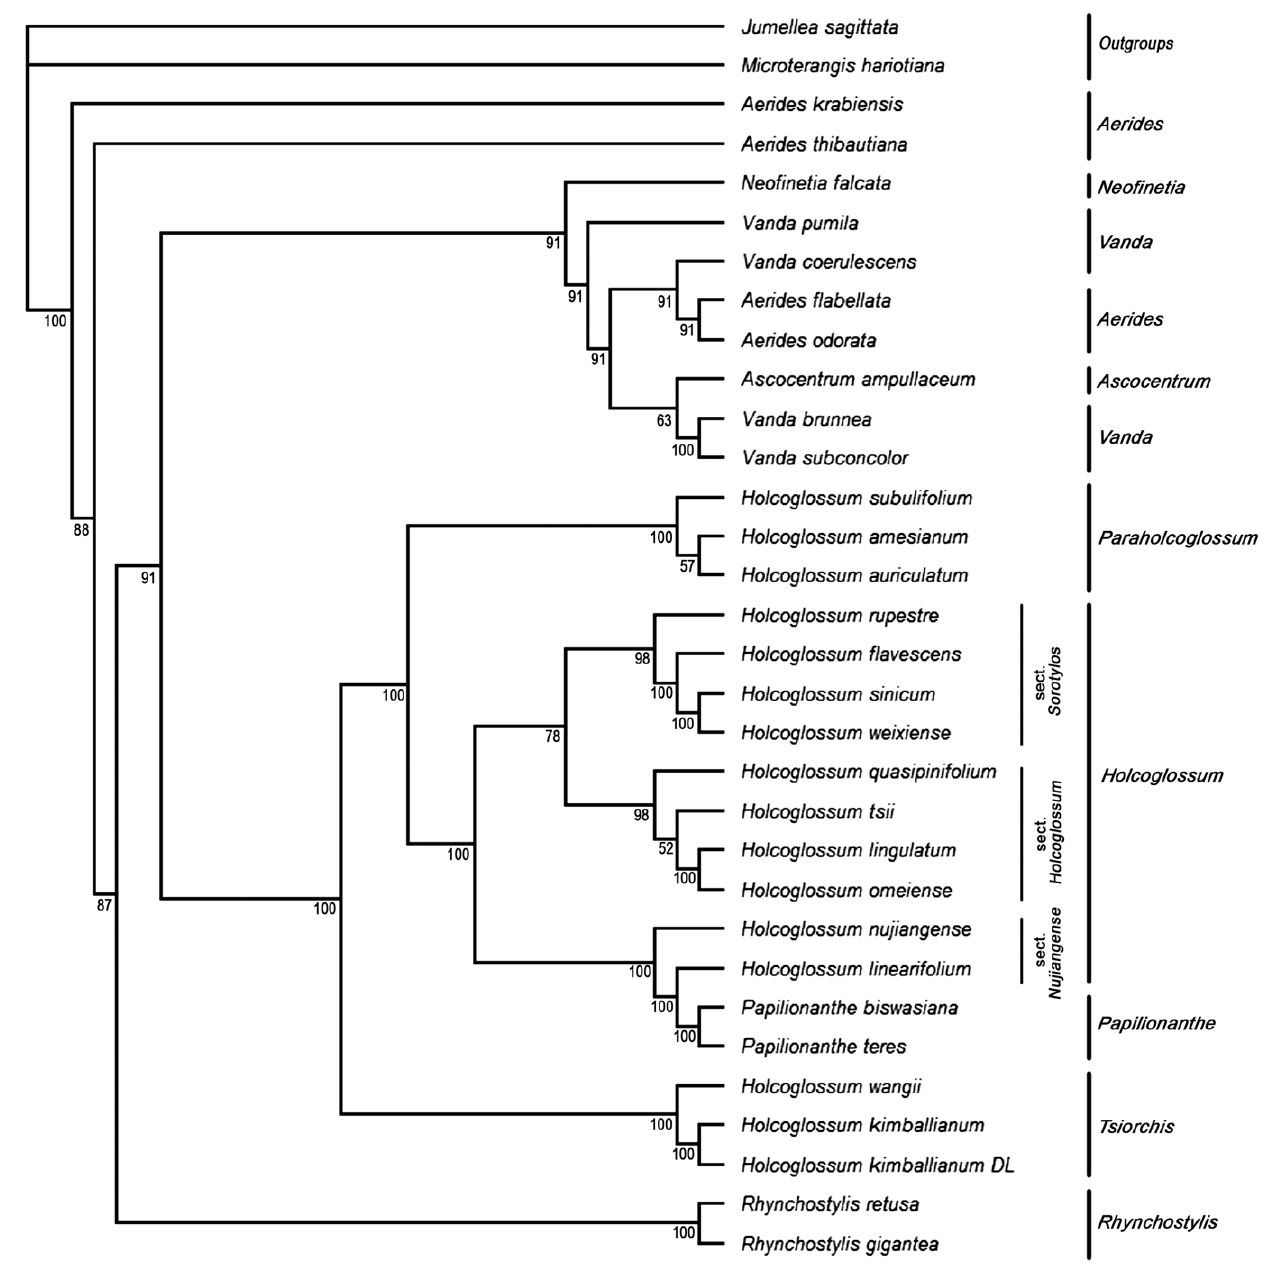
Figure 1. Bayesian consensus trees based on the last 30,001 maximum likelihood trees for the combined datasets of ITS, trnL-F , and matK . The Bayesian posterior probability ( 6 100) is given below the branches.